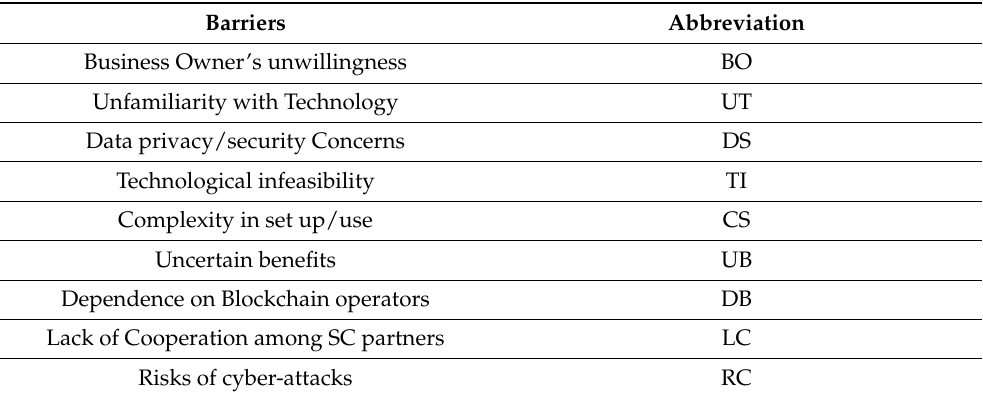
Table 4. The abbreviation of customized barriers.